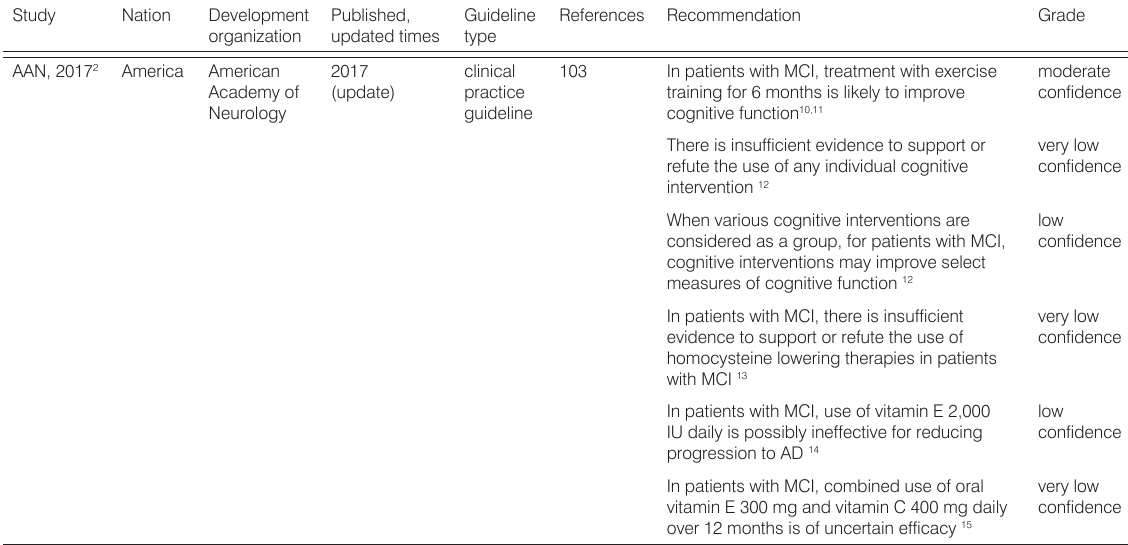
Table 1. Basic characteristics of the included